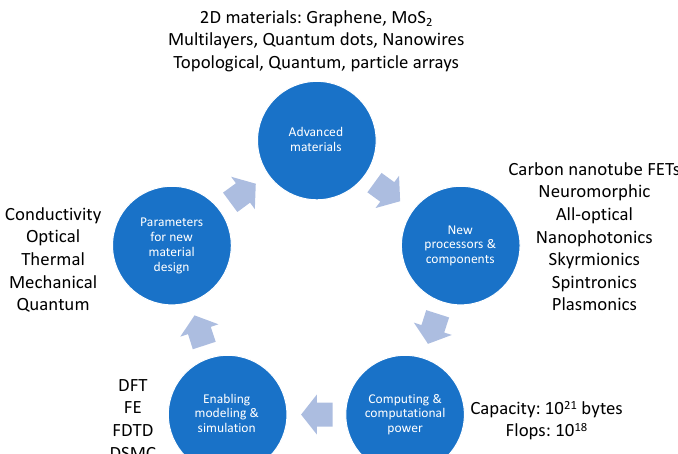
Figure 8. The process loop for the development of new processors. Examples of computational approaches including DFT (density functional theory), finite elements (FE), finite difference time domain (FDTD), and direct simulation Monte Carlo (DSMC) are given only generically.